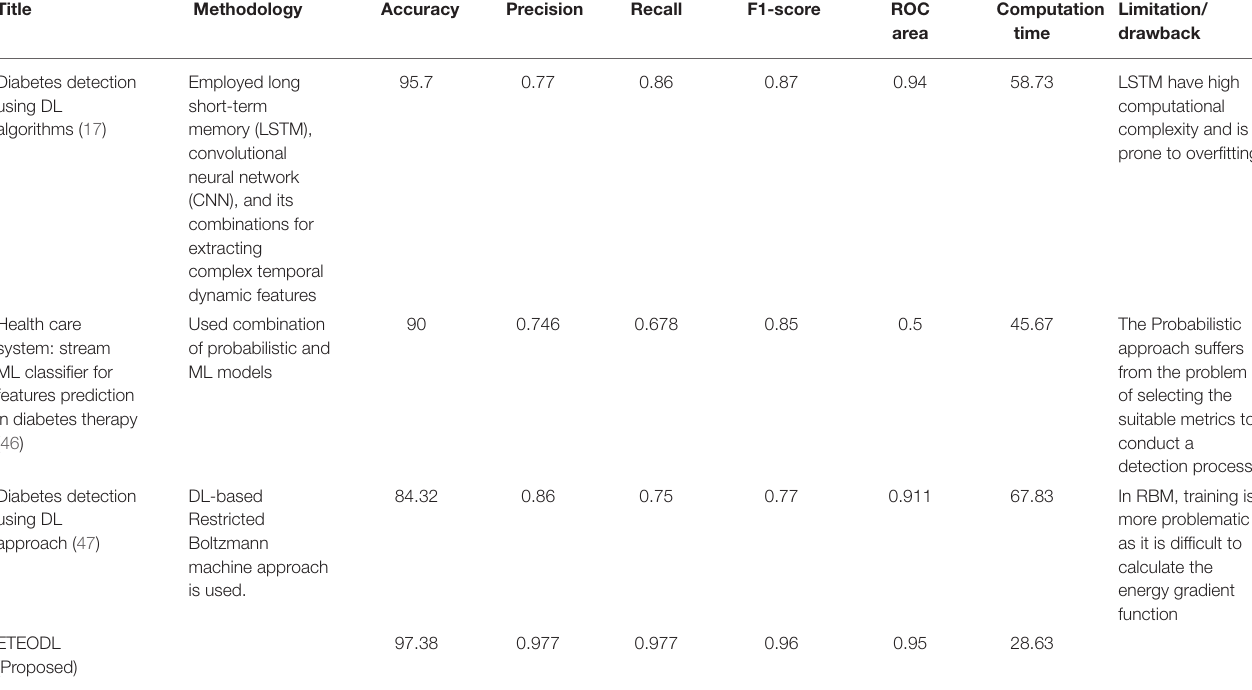
TABLE 3 | Comparison of the proposed model with recent